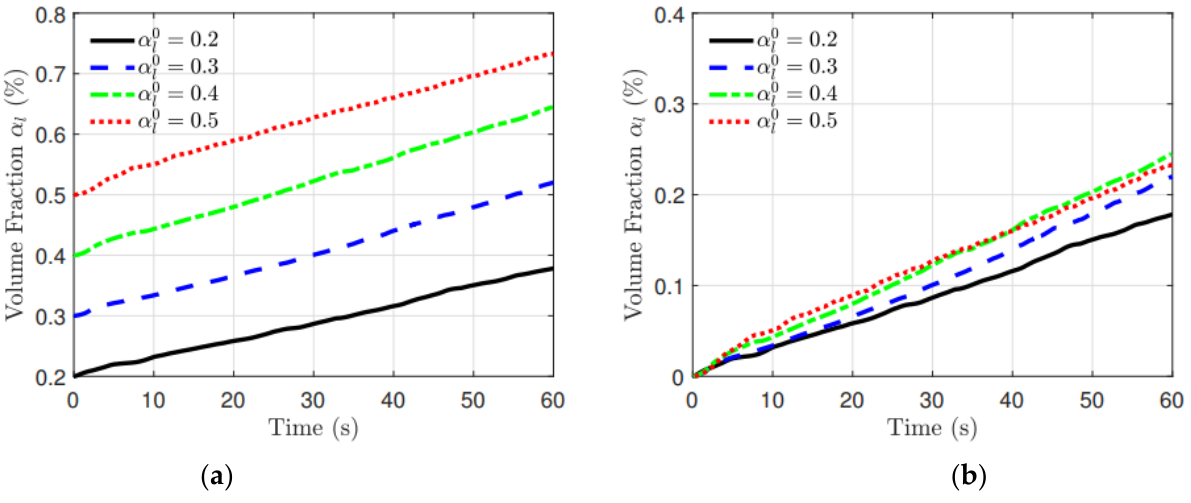
Figure 14. Time history of the volume fraction of the liquid, where the initial volume fractions of the